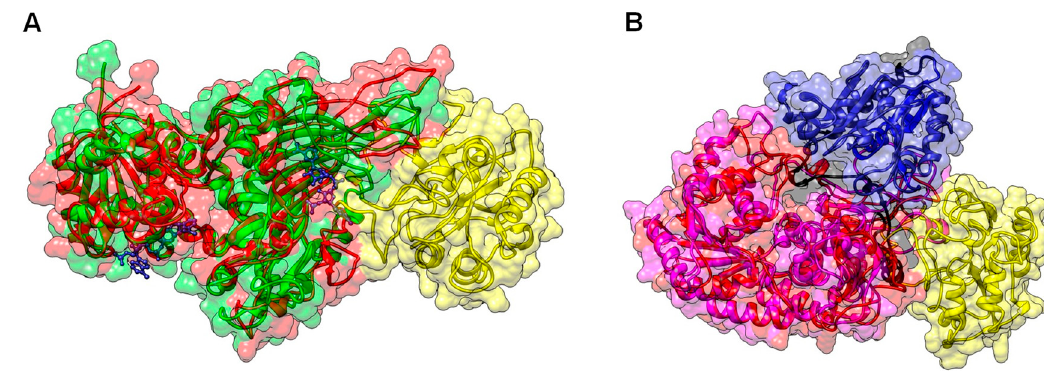
Figure 9. Structural alignment of the minimized model of TvG6PD::6PGL. ( A ) Structural alignment of the human G6PD enzyme (PDB entry 2BH9; green cartoon) and the minimized model of the TvG6PD::6PGL from T. vaginalis (G6PD domain, red cartoon; 6PGL domain, yellow cartoon). The catalytic NADP + and the structural NADP + from human G6PD are shown as blue sticks. ( B ) Structural alignment of the minimized model of TvG6PD::6PGL from T. vaginalis (G6PD domain, red cartoon; 6PGL domain, yellow cartoon) and the minimized model of the fused G6PD from G. lamblia (the G6PD domain is represented in magenta cartoon, the 6PGL domain is represented in blue cartoon, and the dark-colored loop is located between the G6PD and 6PGL interfaces).